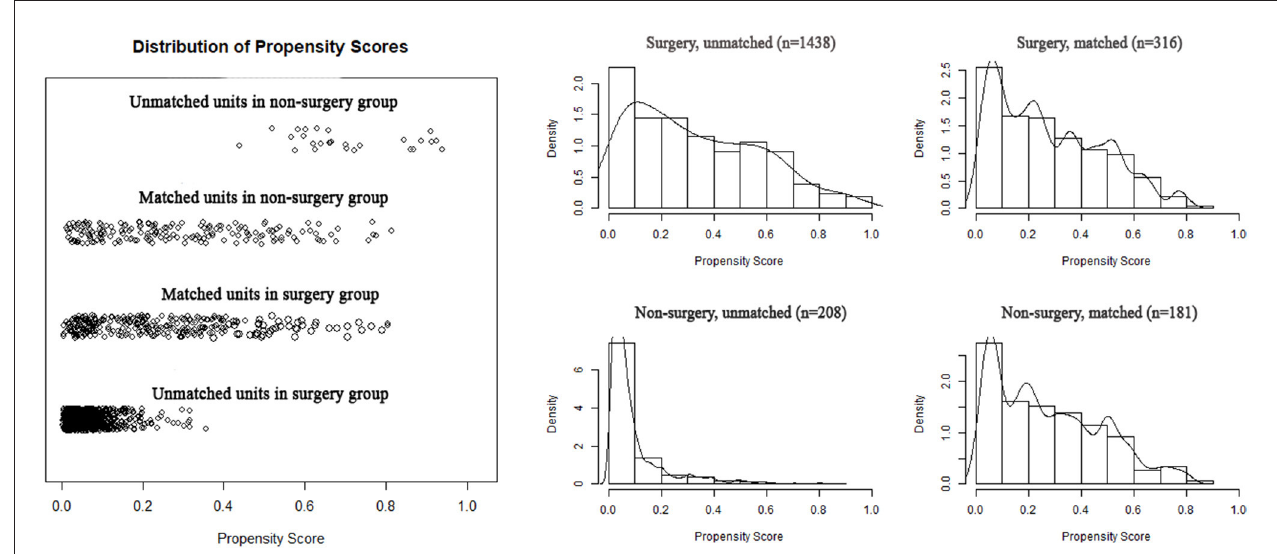
FIGURE 4 | Distribution of propensity score before and after propensity score